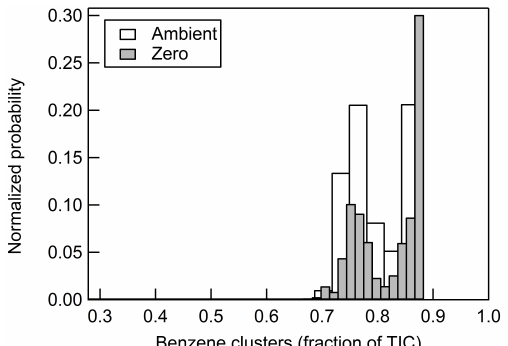
Figure 7. Inlet and instrument response to a prompt switch from ambient sampling to a zero air addition. The first rapid decay is attributed to the gas evacuation time ( τ 1 ) and the second decay is attributed to the inlet wall-equilibration time ( τ 2 ) . Best fit estimates of τ 1 for H 3 O + (H 2 O), DMS, and monoterpenes ranged between 2 and 3s, in agreement with the volumetric evacuation time of the sample inlet (3.6 seconds). τ 2 was determined to be 22, 1.2, and 2.5s, respectively.